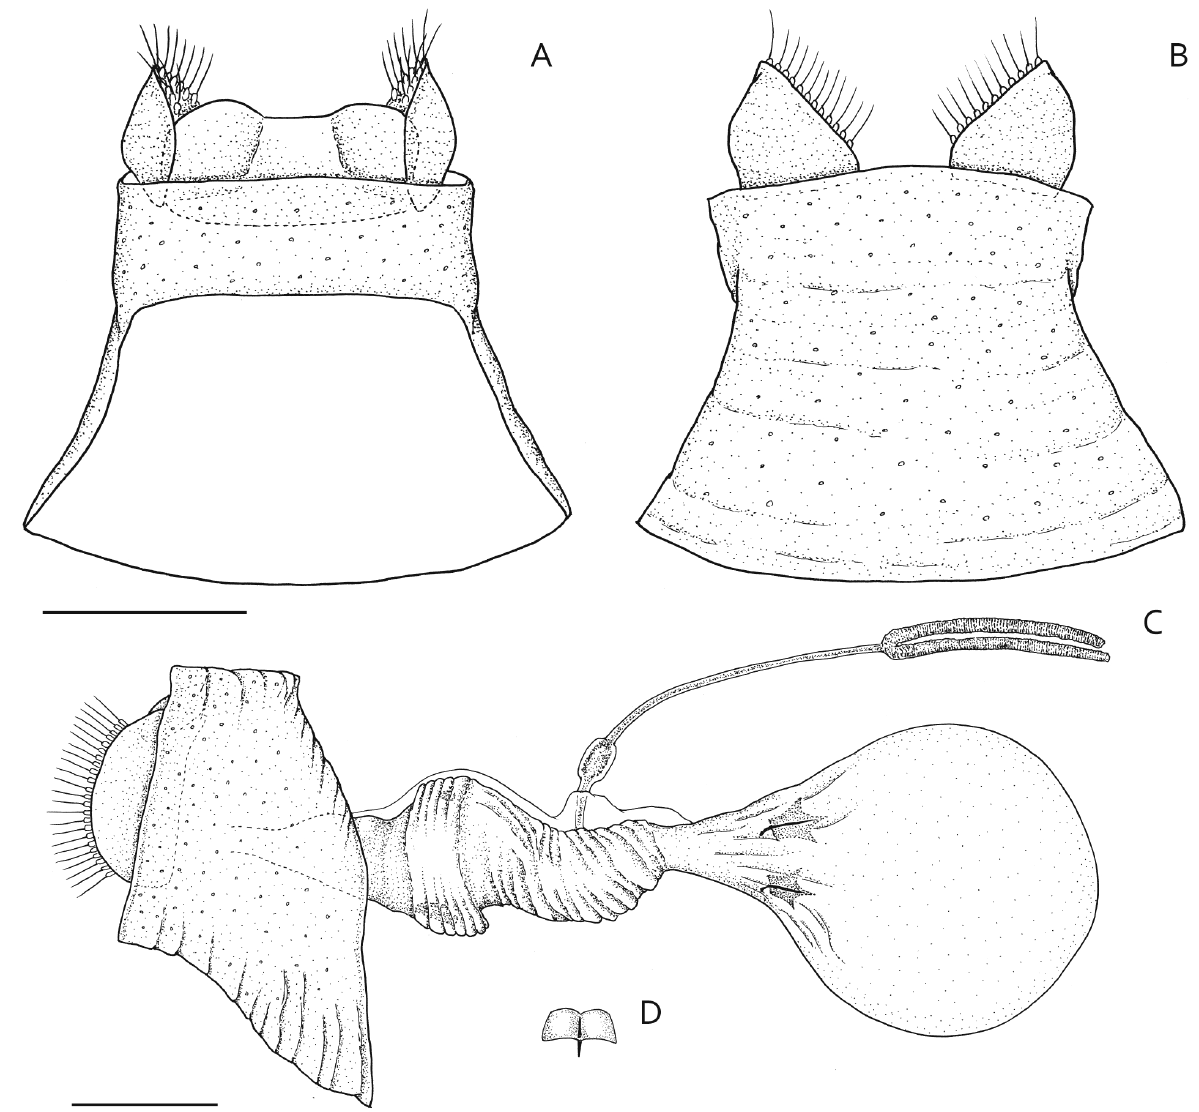
Figure 16. Female genitalia of Issikiomartyria akemiae A: genitalia capsule, dorsal view; B: ditto, ventral view; C: female genitalia, lateral view; D: genital sclerite. Scale bars: 0.2